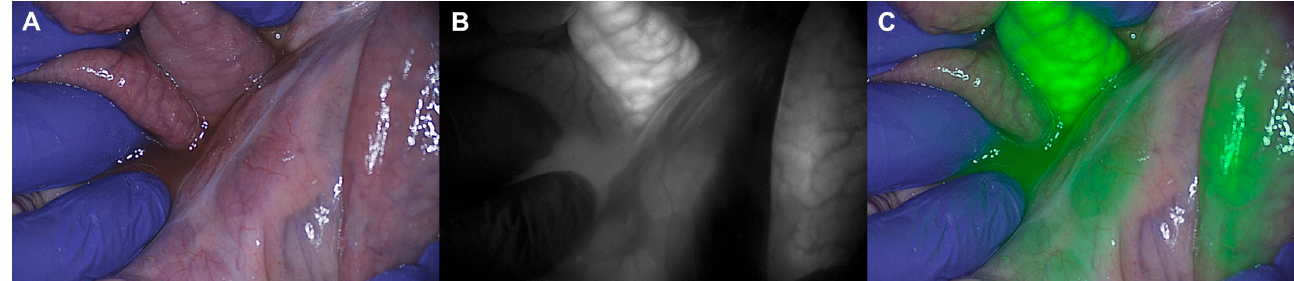
Figure 5. Picture of mesenteric edema after 40 min of IV ICG administration. ( A ) The RGB image. ( B ) Fluorescence picture at 800 nm ( C ) Overlay fluorescence picture at 800 nm. MB is hydrophobic and does not bind to albumin as opposed to ICG. Jun Li et al.